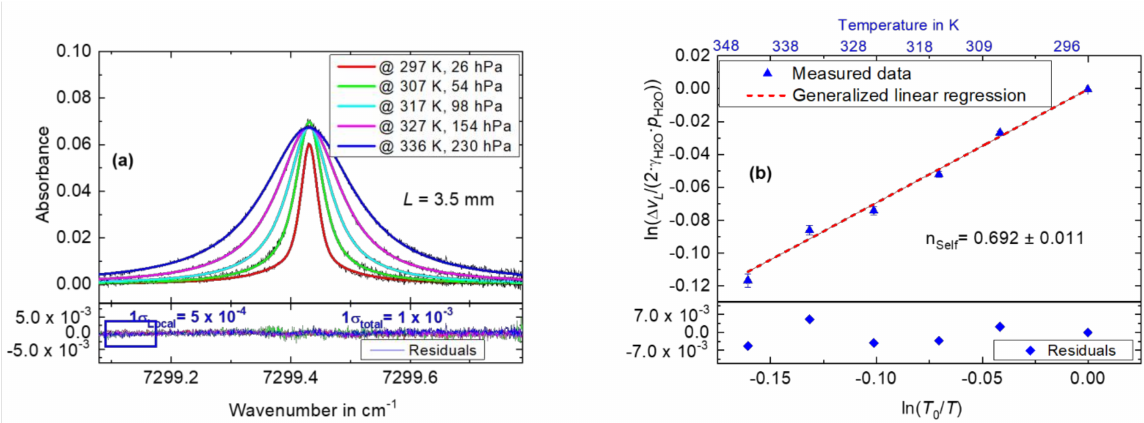
Figure 4. H 2 O self-broadening measurements. ( a ) Plot of the measured absorbance data at different temperatures and pressures as a function of wavenumber. Voigt profiles (solid lines with different colors) are fitted to the measured data. Bottom panel: residuals from the different Voigt fits. ( b ) A GLR applied to ln ( ∆ v L / ( 2 · γ H2O · p H 2 O ) versus ln ( T 0 / T ) to determine the temperature dependence exponent of self-broadening n H2O. Root mean square of the error (RMS error): 1.12 × 10 − 16 . Top panel: measured gas temperature at the respective